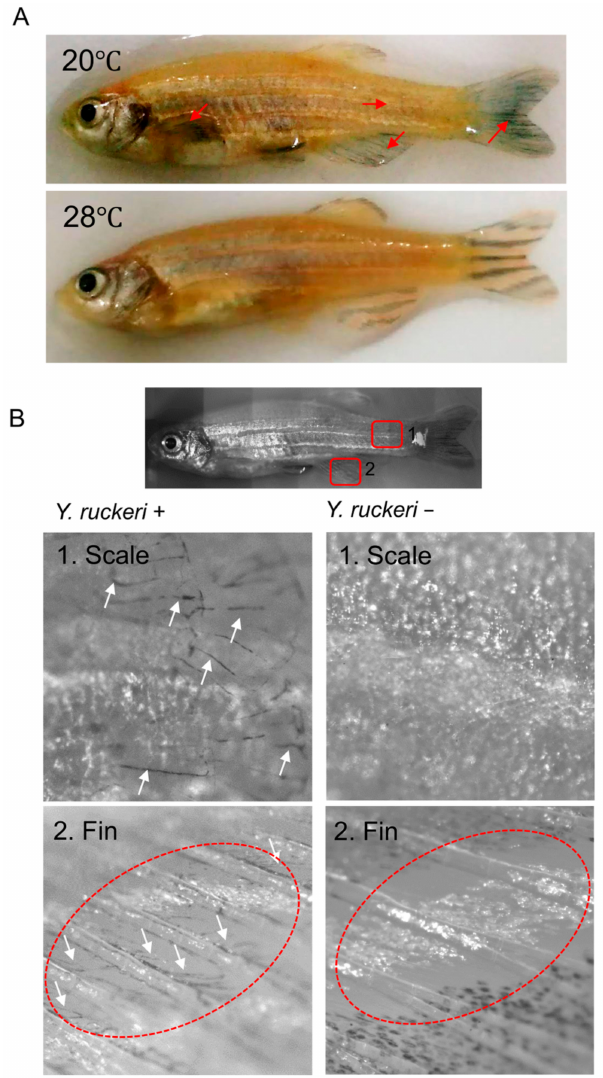
Figure 2. In vivo imaging of the Yersinia ruckeri on the fish skin. ( A ) Whole views of zebrafish 48 h after pathogen challenge at 28 ◦ C and 20 ◦ C. Red arrows represent the positive areas showing X-gal staining of Y. ruckeri expressing lacZ . ( B ) Detailed observation of fish with ( Y. ruckeri +) and without ( Y. ruckeri − ) pathogen challenge at 20 ◦ C under a microscope. Microscopic images of scales around a tail fin (1) and an anal fin (2) are shown. Y. ruckeri cells stained with X-gal were seen as black dots along with uneven patterns of the surface (white